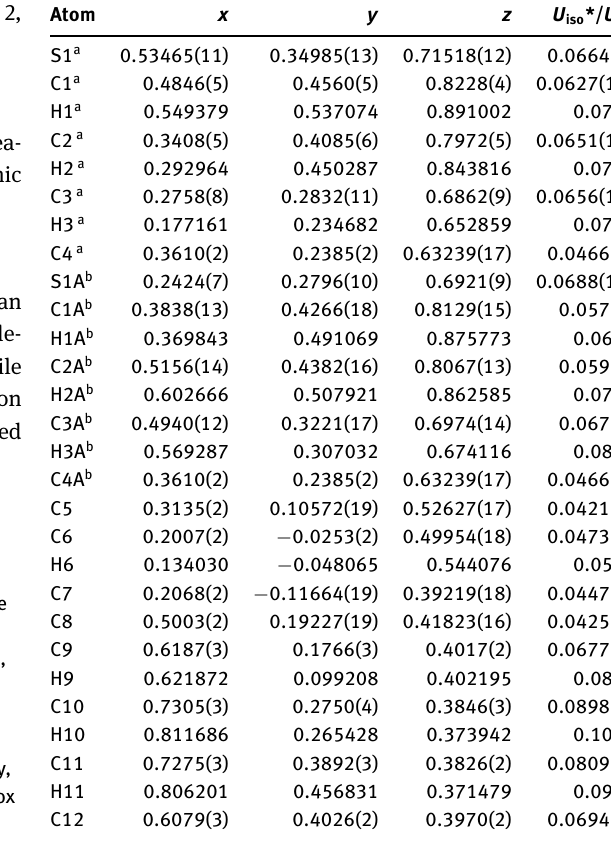
Table 2: Fractional atomic coordinates and isotropic or